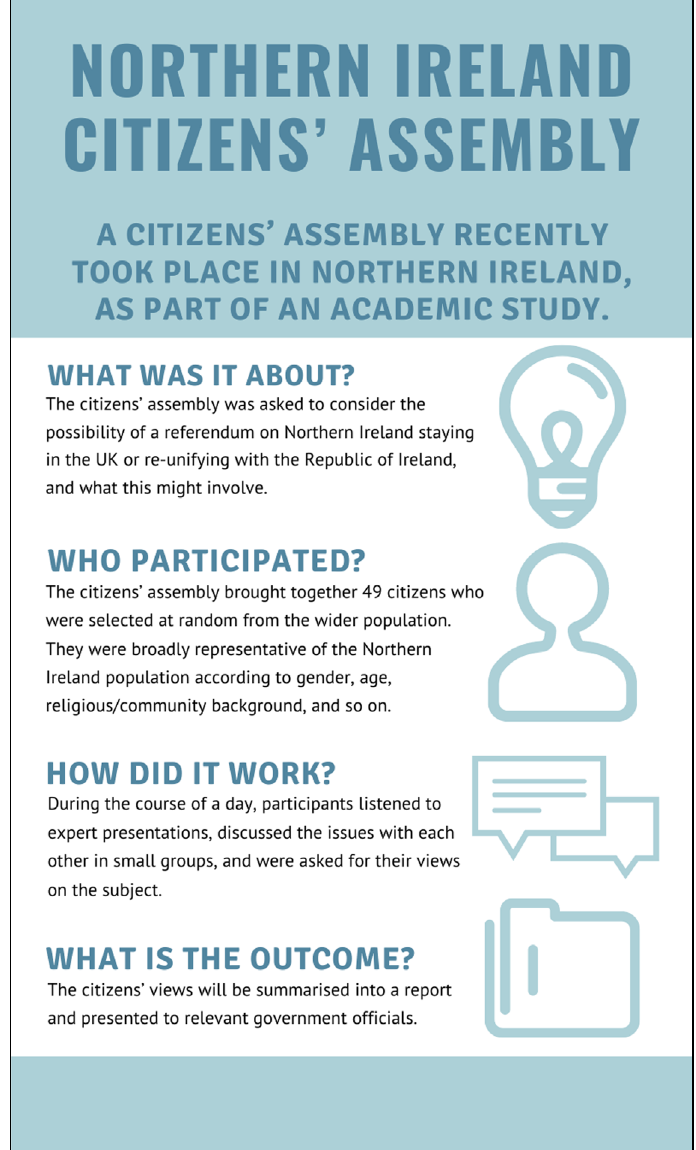
Figure 1: Infographic presented to survey respondents on the